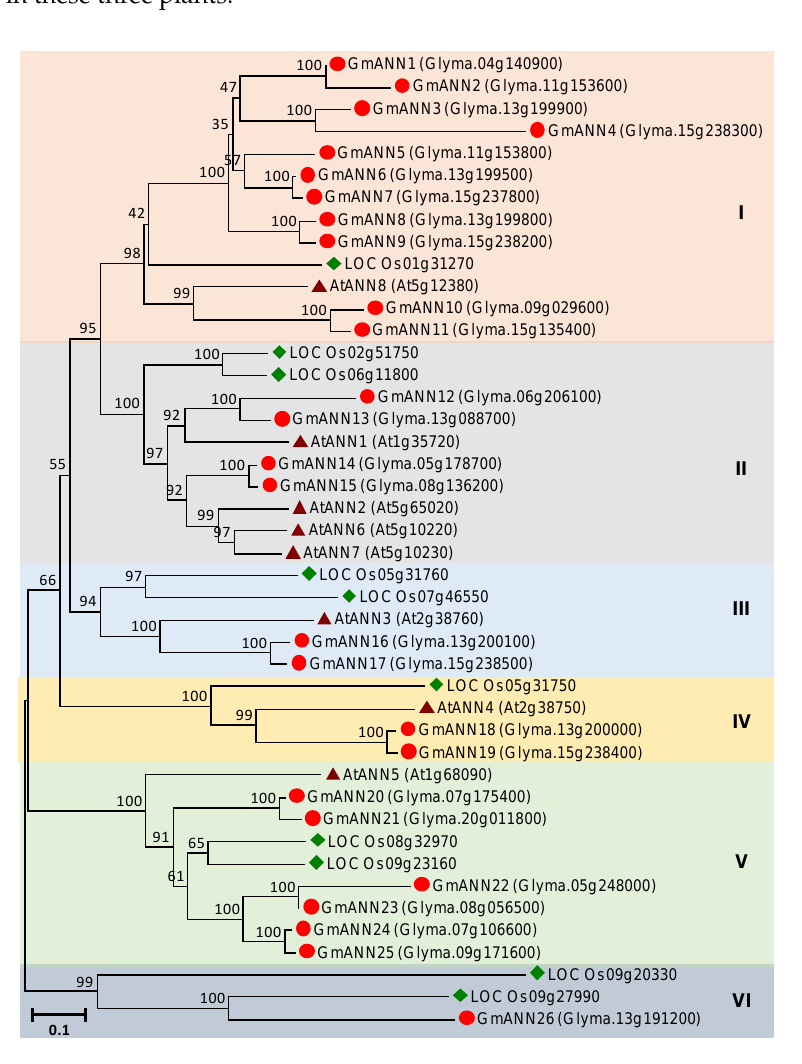
Figure 7. Unrooted phylogenetic tree of the annexins (ANN) family proteins from soybean ( Glycine max ), rice ( Oryza sativa ), and Arabidopsis thaliana . Soybean ANNs are marked with red circles, Arabidopsis ANNs were marked with purple triangles, while rice ANNs were marked with green diamonds. The bar indicates the relative divergence of the sequences examined, and bootstrap values are displayed next to the branch. Roman numerals designate the subfamilies.